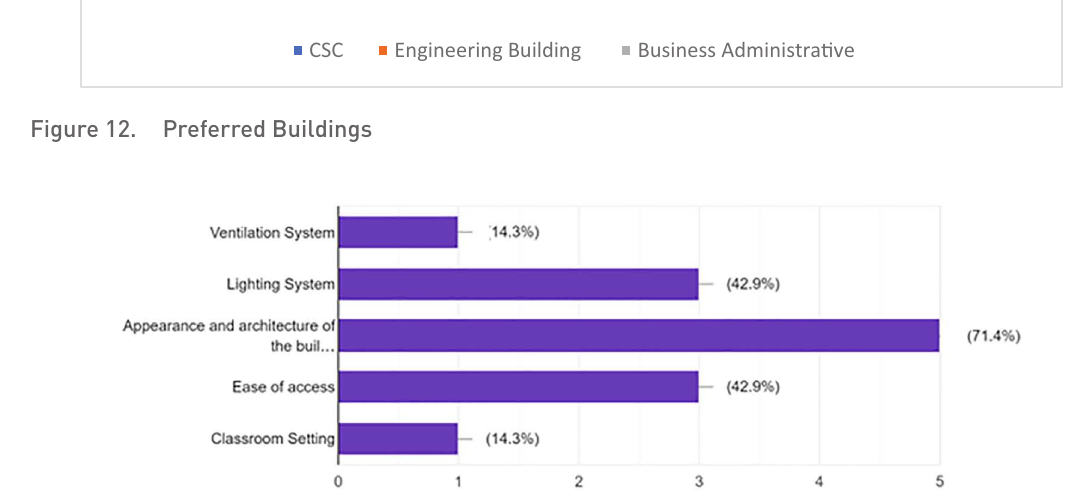
Figure 13. Factors of Socio-